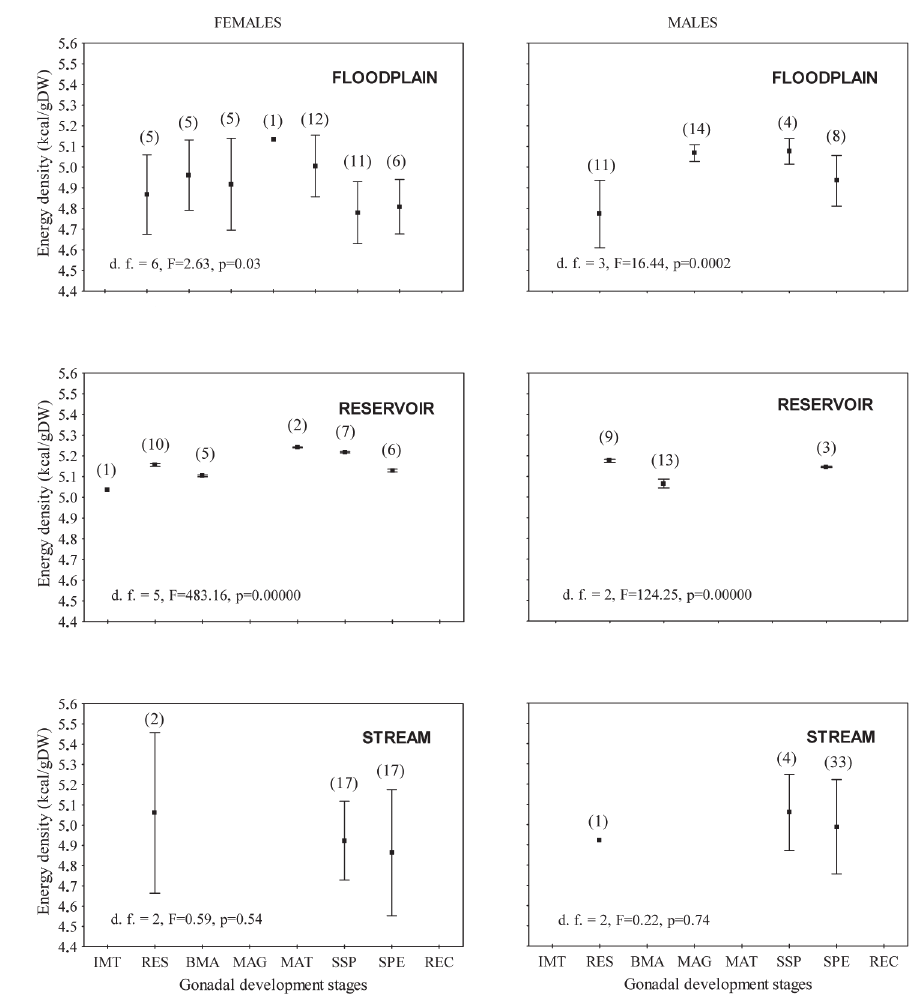
Fig. 2. Mean ± standard deviation for muscle energy density of Loricariichthys platymetopon, at different gonadal development stages (immature = IMT; resting = RES; beginning of maturation = BMA; maturing = MAG; mature = MAT; semi-spent = SSP; spent = SPE; recovery = REC), in the upper Paraná River floodplain, Rosana Reservoir and Diamante Stream. Number of specimens between parentheses. One-way ANOVA are presented for each